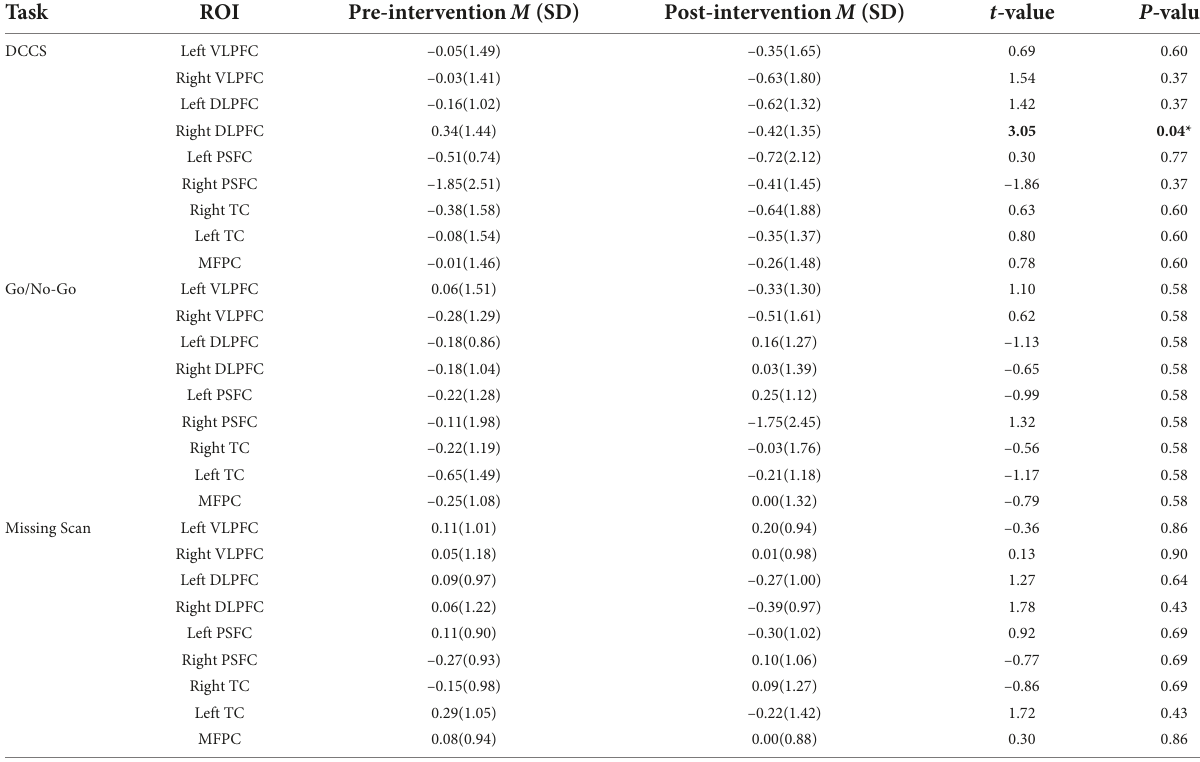
TABLE 3 Comparison of increases in HbR before and after the intervention (full sample).